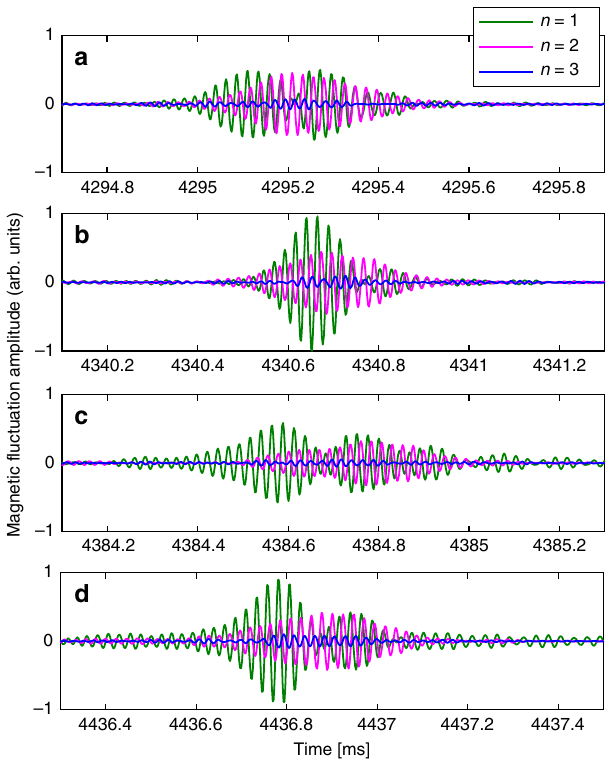
Fig. 6 Experimental con fi rmation of the multi-mode nature of ALEs. Panels a – d show a 12 ms time window around one of the four ALEs that can be seen in Fig. 1. The magnetic fl uctuation signal that is plotted here in arbitrary units (arb. units) was measured in JT-60U shot number E048424 using a toroidal array of saddle loop coils. The raw electric signal was sampled at 500 kHz, time-integrated, and band-pass fi ltered using a zero- phase forward and reverse digital Butterworth fi lter for the frequency range 30 – 70 kHz. The result was then decomposed into toroidal Fourier harmonics with mode numbers n = 1, 2, 3, whose time traces are plotted here in different colours. One can see that modes with n = 1 and n = 2 reach large amplitudes during each ALE. The measurement sensitivity is signi fi cantly lower for modes with n = 3 and higher; namely,